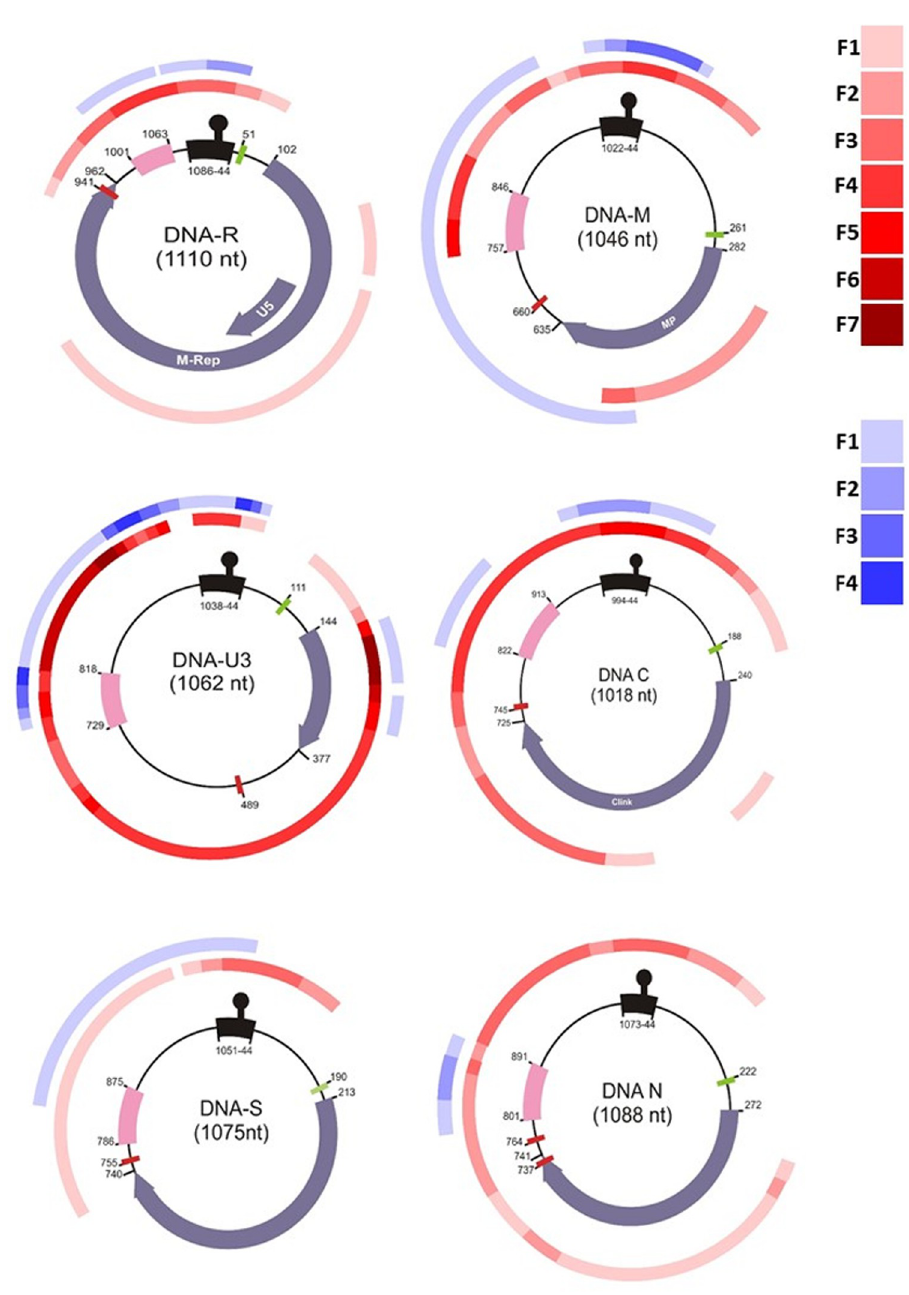
Fig 3. Recombination map of Banana bunchy top virus genome. The genomic components of BBTV are represented with inner circle having CR-SL, CR-M and ORF in black, pink and blue colours respectively. The nucleotide coordinates are corresponding to P.TJ1 isolates for reference. The red circles represent the intergenomic recombination, while the blue circle represent the intragenomic recombination. The intensity of colours was used to depict the frequency of recombination at a particular region using the key above. The recombinant events described in S2 and S3 Tables are marked. The figures were not drawn on scale. BBTV components DNA-N (population of Tonga) and DNA-U3 (population of Australia, Tonga, China, Philippines and Congo) showed on average 100% and 90% increased diversity of recombinant populations. which indicates that there is a possibility that with component